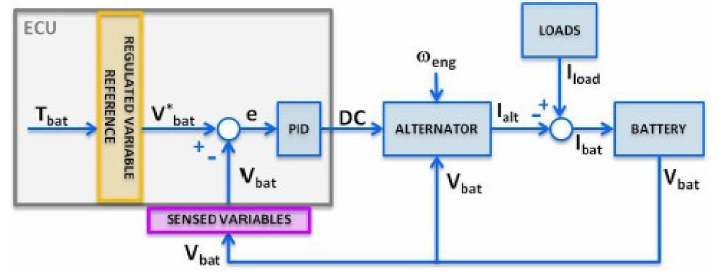
Figure 10. PID controller for alternator voltage regulator [15].